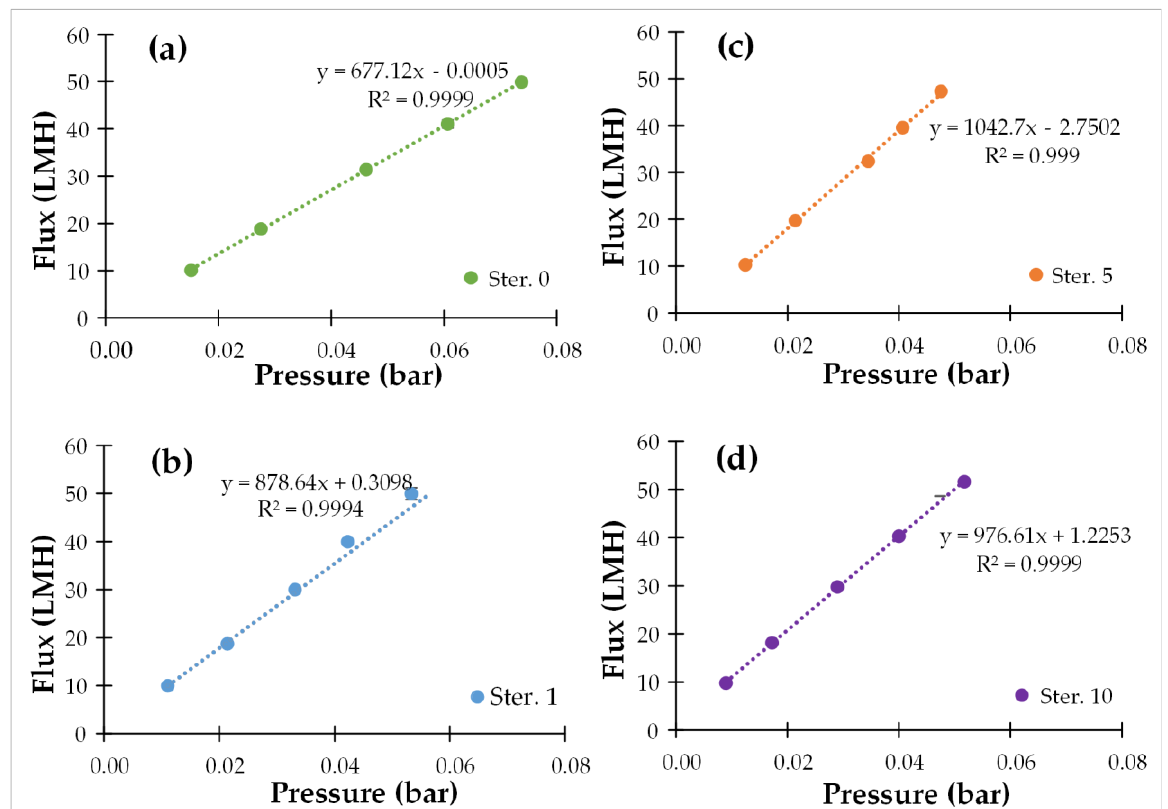
Figure 2. Pure water flux test results: ( a ) before sterilization (ster. 0); ( b ) after the 1st sterilization cycle; ( c ) after the 5th sterilization cycle, and ( d ) after the 10th sterilization cycle. The initial pure water permeance of the membrane module (i.e., before any sterilization cycle) was 677 LMH/bar, while after the 1st, 5th, and the 10th cycles of sterilization, pure water permeance was 878, 1043, and 977 LMH/bar, respectively. These values correspond to permeance before correction according to Equation (1). Data of temperature-corrected pure water permeabilities are reported in Table 4, where it is observed that the temperature-corrected pure water permeance increases to 879 LMH/bar after the first sterilization and fluctuates with a mean 906 ± 49 LMH/bar after the ensuing sterilization cycles. The SD of the 10 pure water permeances after each sterilization cycle is approx. 5.4% of the mean value, which indicates that the permeance is quite constant, varying between 829 (min. value) and 993 (max. value) LMH/bar. The average permeance after each sterilization cycle is approx. 33.8% higher than the initial permeance. This difference between the pristine and the sterilized membrane could be attributed either to the conditioning of the membrane after its first use or the slight increase of the membrane pore size. In general, the sterilization process does not seem to negatively affect the permeance of the membrane, since there are no high fluctuations, or a systematic trend of permeance increase or reduction. This conclusion is also supported by the fact that pure water permeance after sterilization is similar to the reference values of the commercial membrane